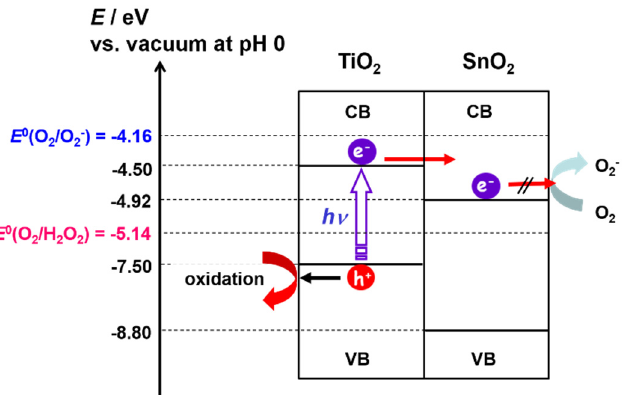
Scheme 1. Energy diagram of the SnO 2 -TiO 2 hybrid-photocatalyzed reaction system.